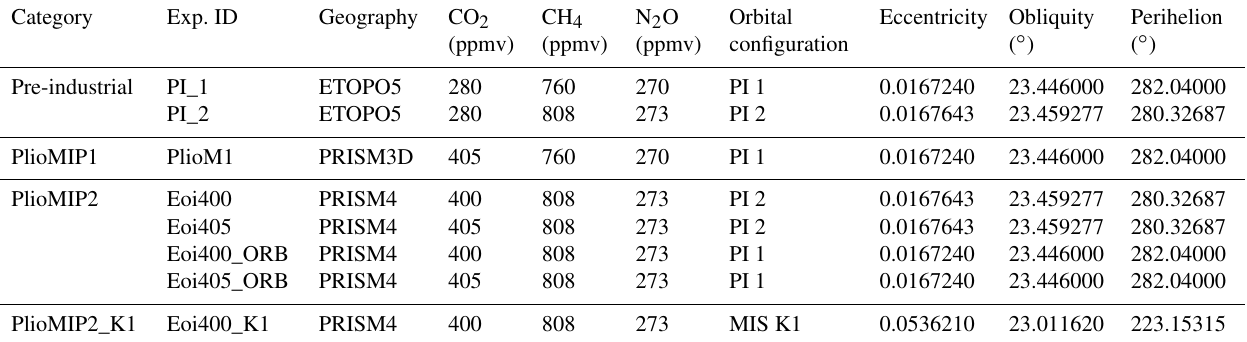
Table 1. Detailed description of experiments including the category of orbital configuration based on two different pre-industrial (PI) and one mPWP-specific setting, as well as specific parameter values and applied geography. Category Exp. ID